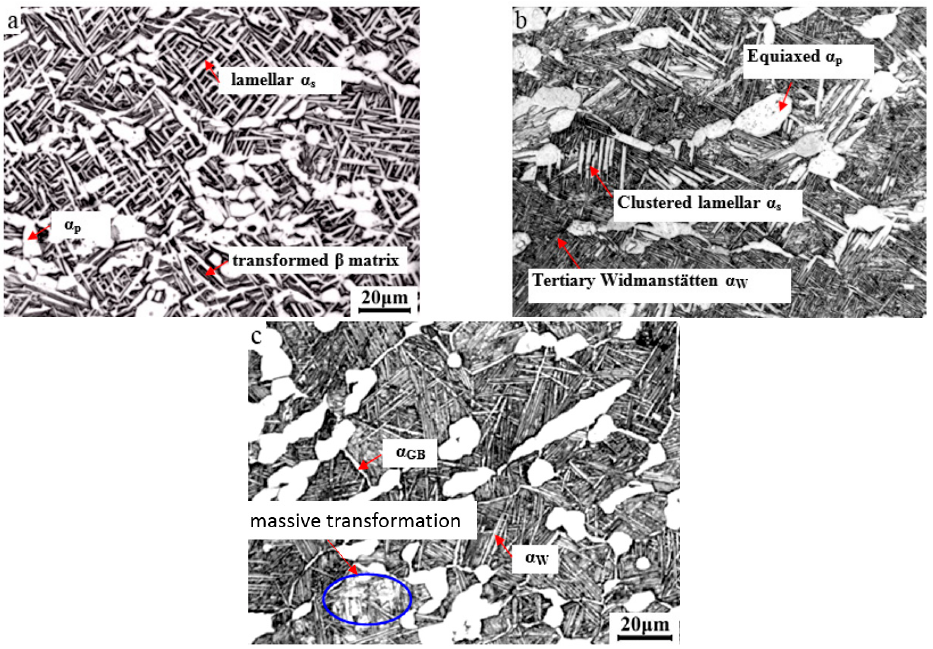
Figure 4. Optical micrographs of TA15 alloy after near- β forging and toughening + strengthening